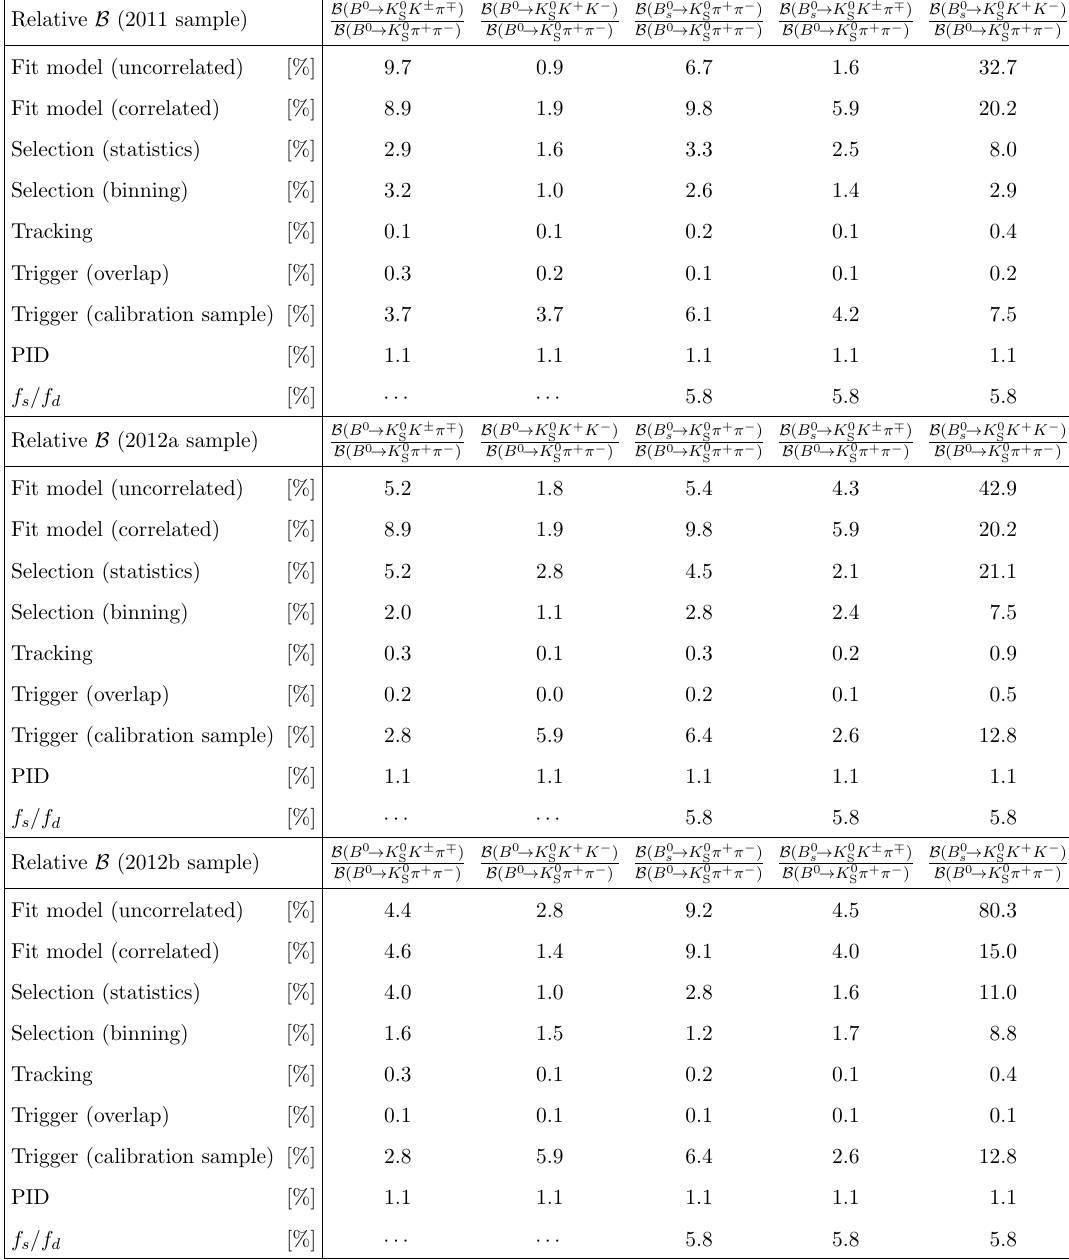
Table 7 . Systematic uncertainties on the ratios of branching fractions for long K 0 All uncertainties are relative and are quoted as